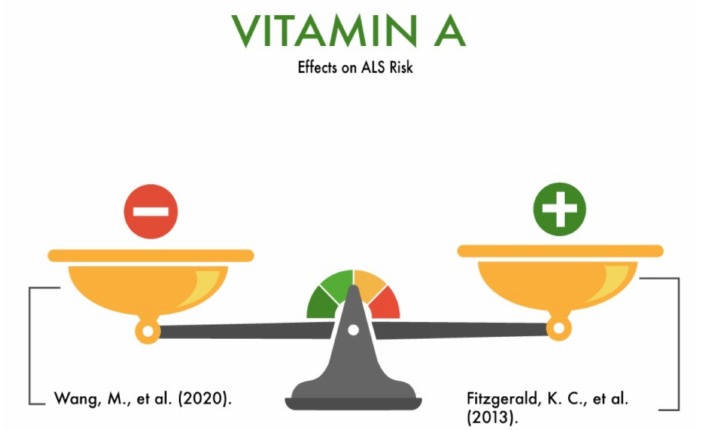
Figure 1. The effect of vitamin A on the risk of developing amyotrophic lateral sclerosis